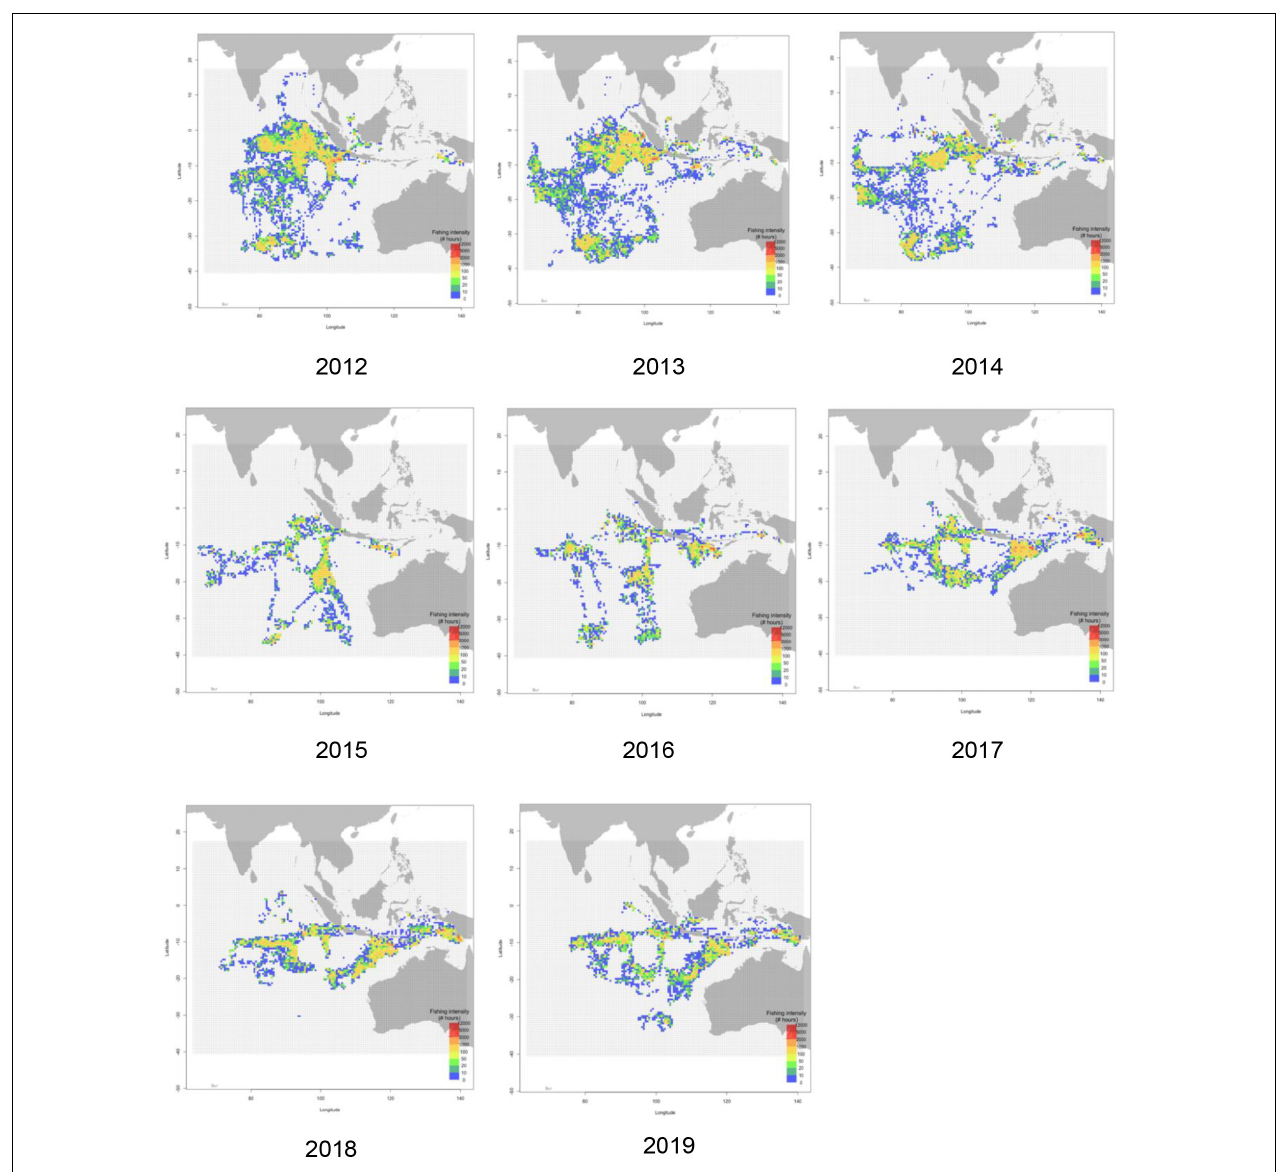
FIGURE 6 | Spatio-temporal distribution of fishing events from 2012 through 2019, represented as the total fishing duration (hours) per 0.5 × 0.5 ◦ grid